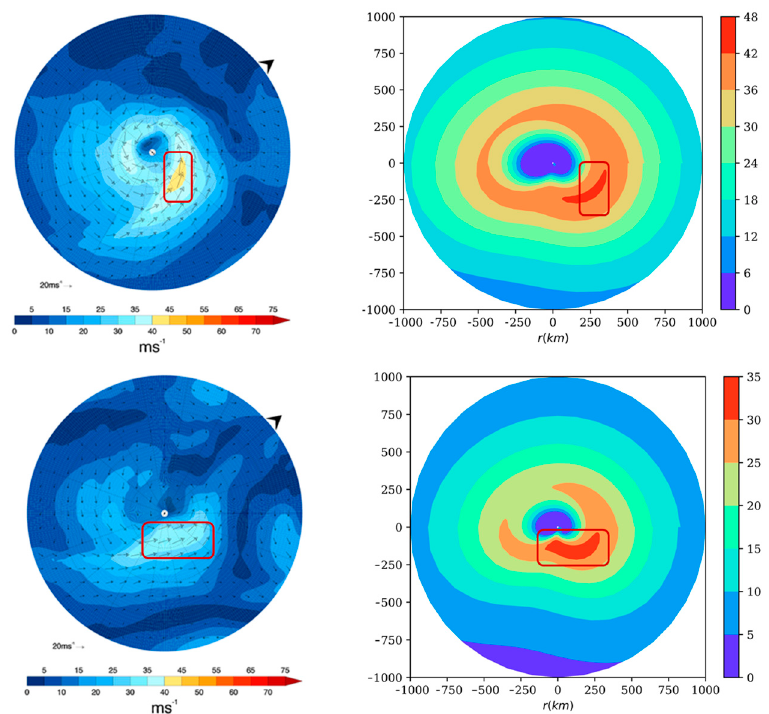
Figure 5. Comparison between reanalysis ( left ) (Dacre et al. 2012) and simulated ( right ) wind fields of ETC #1 (2004) ( top ) and ETC #2 (2006) ( bottom ) (Note: the red rectangles indicate the region of the most destructive winds).